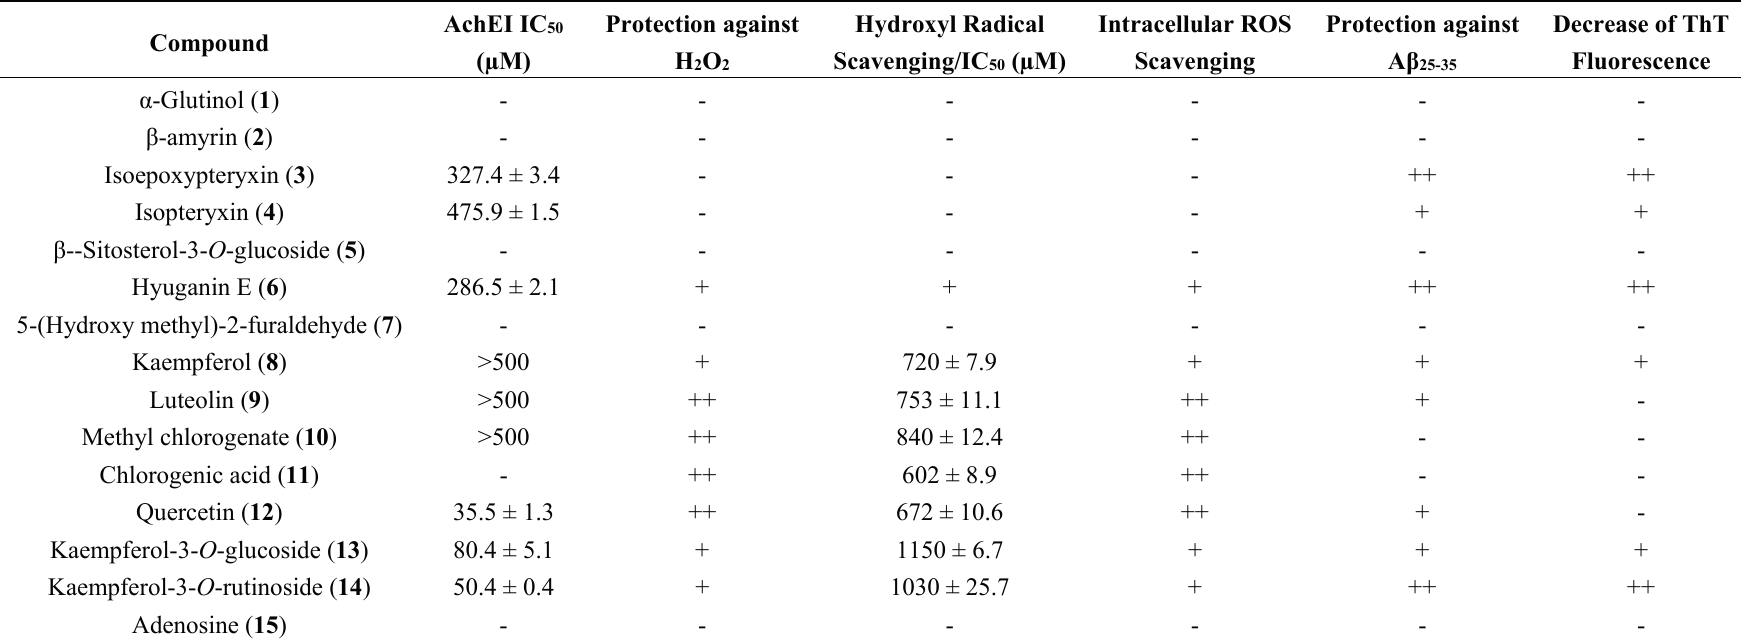
Table 4. Summary of the activity of the isolated compounds in the tested